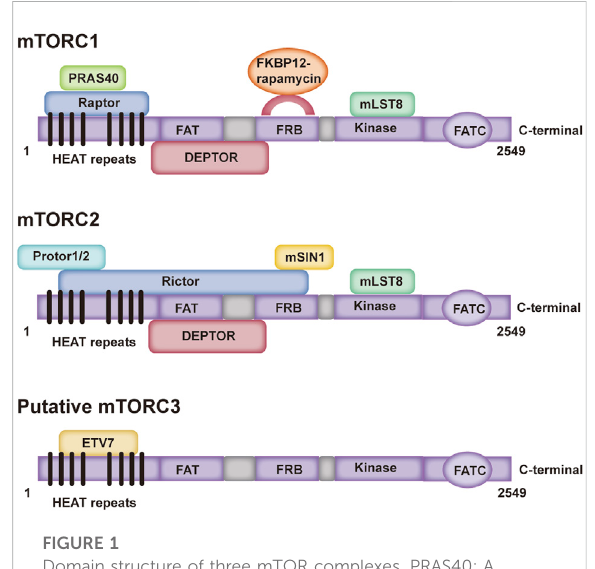
FIGURE 1 Domain structure of three mTOR complexes. PRAS40: A known Akt substrate is a 40 kDa proline-enriched protein; Raptor: Regulation related proteins of mTOR; FKBP-12: a prototype member of the immune af fi nity protein FKBP (FK506-binding protein) family capable of binding to the immunosuppressive drug FK506 (tacrolimus); mLST8: mammalian lethal with SEC13 protein eight;DEPTOR:itcaninteractwithrictor;Protor:proteinobserved with rictor; Rictor: rapamycin-insensitive companion of mTOR; mSIN1: mammalian stress-activated protein kinase interacting protein; ETV7: ETS variant transcription factor